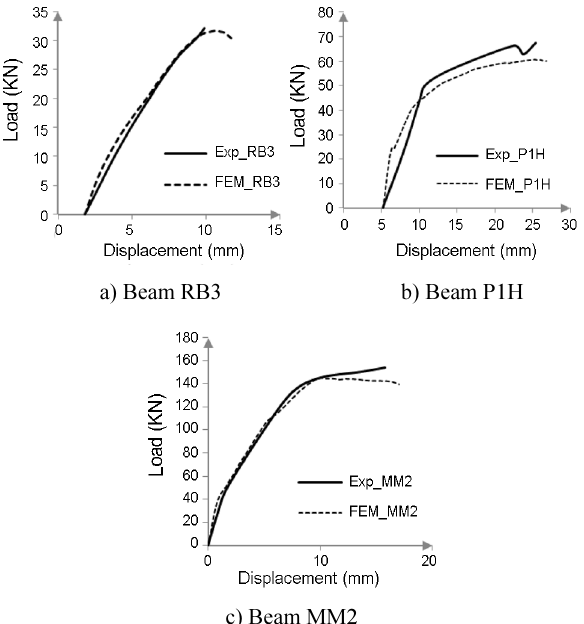
Fig. 15. Verification results for strengthened beams with pre- damaged Table 7. Parametric matrix to investigate the effects of existence of cracks in the models Concrete Group